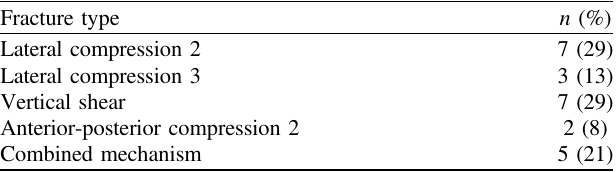
Table 1. Pelvis injury pattern – young and burgess classi fi cation.